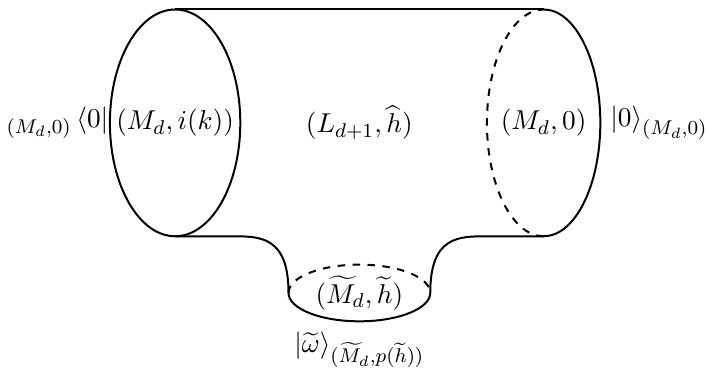
Figure 2 . The geometric con(cid:12)guration de(cid:12)ning ! K in